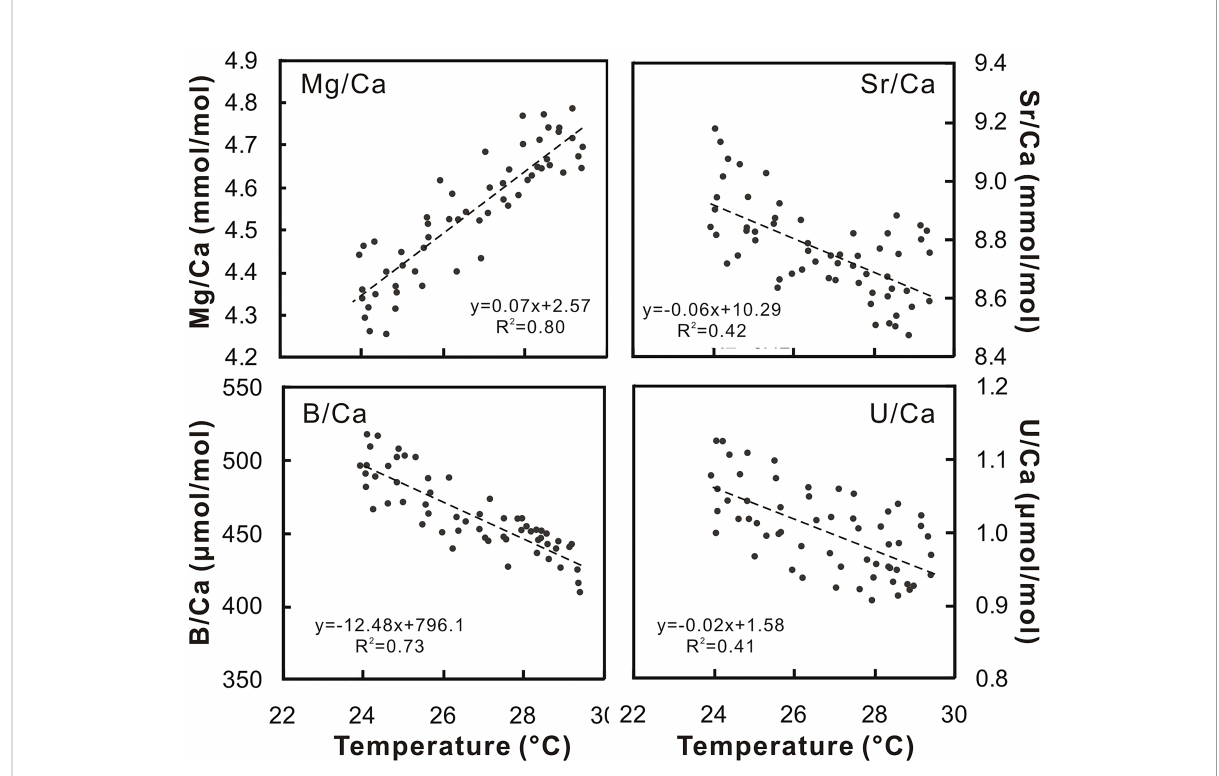
FIGURE 4 Scatter plots for the trace element ratios and SST. The correlation coef fi cients for these equations are signi fi cant, ranging from 0.90 to 0.64.